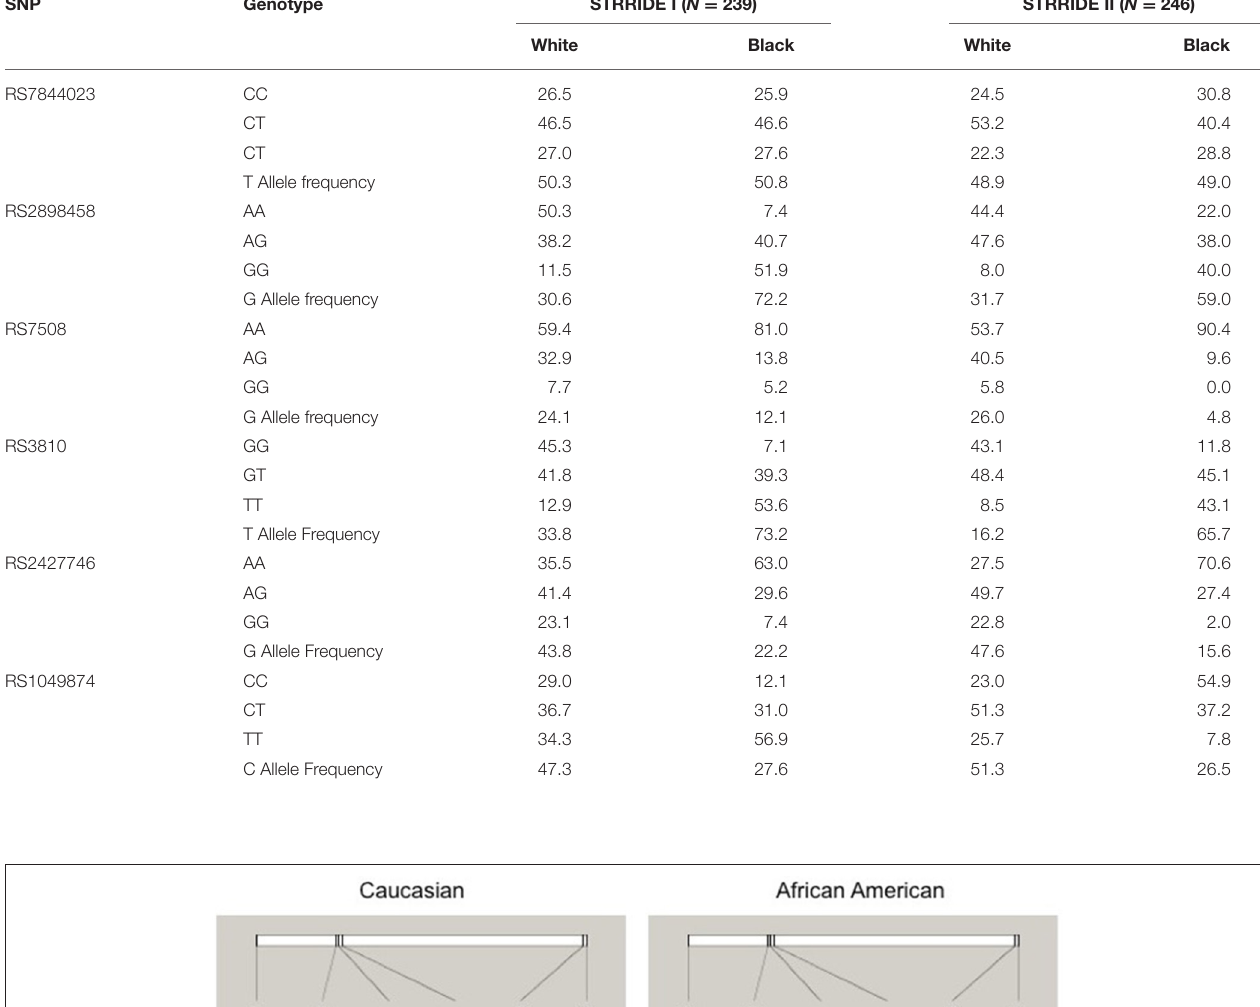
TABLE 2 | Genotype Frequency by Race.